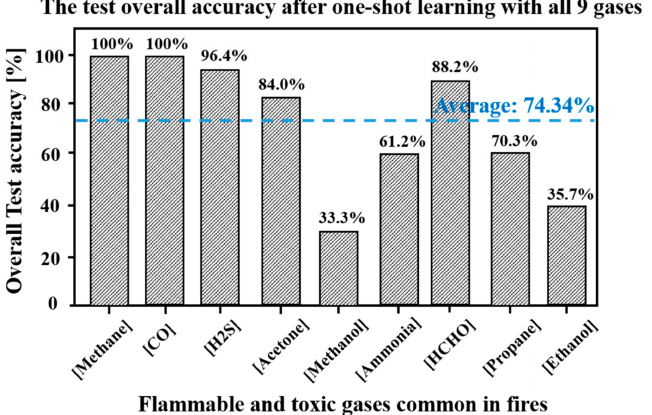
Figure 7. The overall test accuracy after one-shot learning gases with all 9